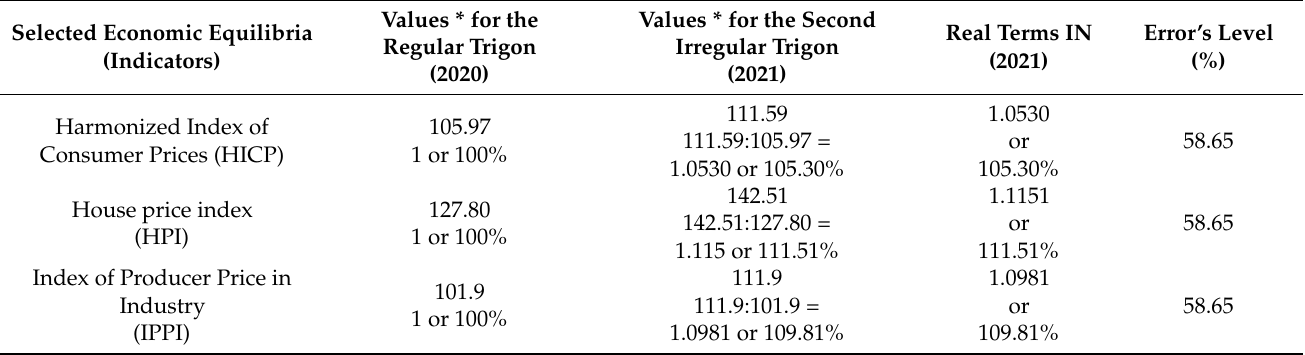
Figure 2. MID-specific dual graphics in “ 3-gon ” GAIN. Table 2. A list of values of essential indicators of MID in the universe of prices adequate for a prospective “ trigon ” based on Eurostat data detailed as IN for “ 3-gon ” GAIN.